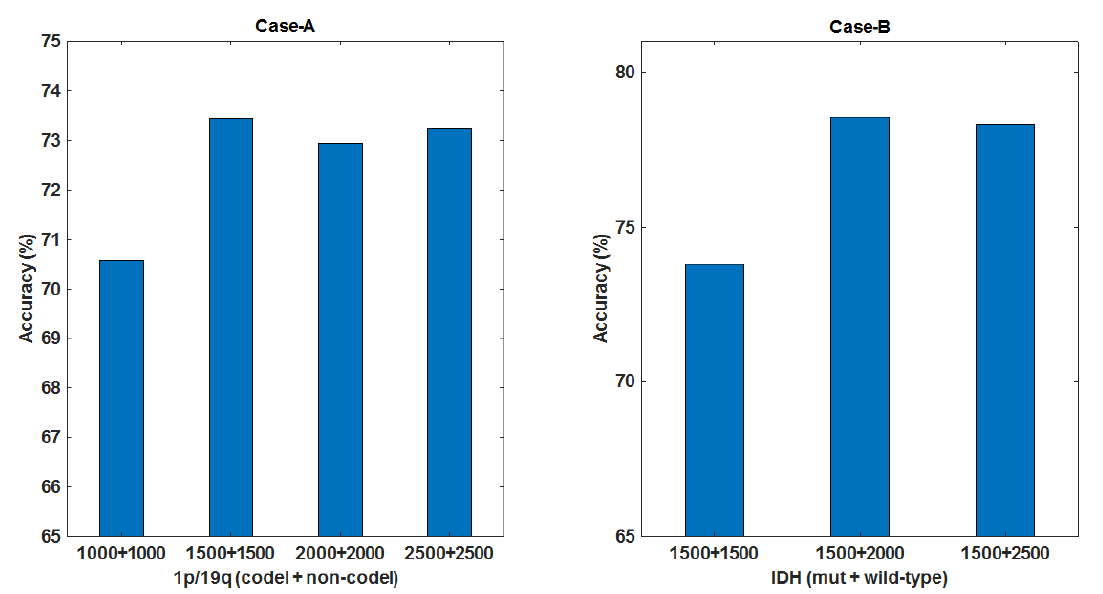
Figure 9. Test accuracy vs. number of augmented data used for pre-training. Left: Case-A: equal number of augmented images are used for each class. Noting in the horizontal axis, (1500 + 1500) is the augmented data size selected. Right: Case-B: more number of augmented images are